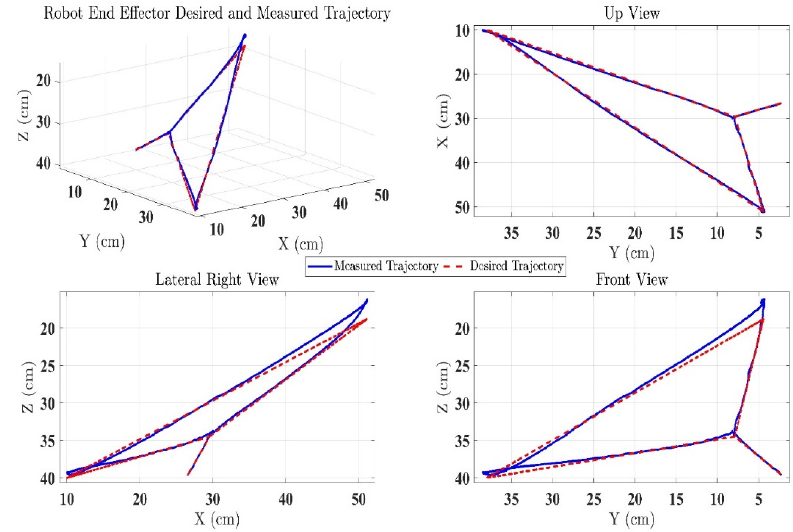
Figure 4. SREx’s trajectory tracking performance in Cartesian space under the proposed controller.